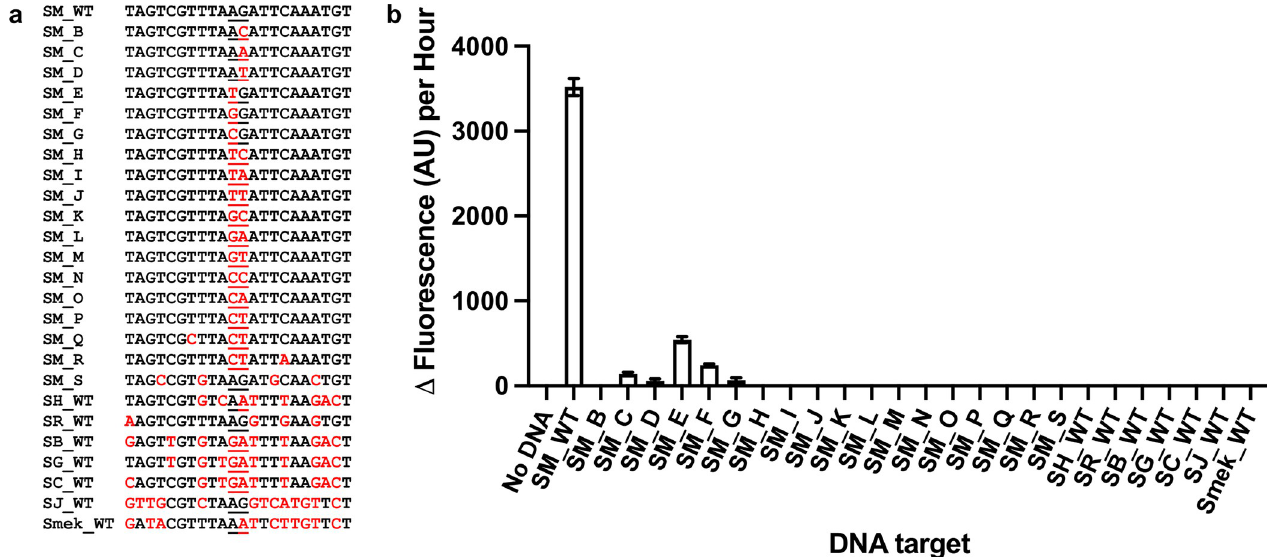
Fig 2. Biosensor ligation junction and S . mansoni probe set specificity. a , DNA targets tested. SM_WT is the target region probes SM_A1 and SM_B1 are designed to recognise. SM_B to SM_S have single, double or multiple base changes from that of SM_WT as indicated in red. The ligation junction for the probes is underlined. The corresponding target region for the other related Schistosoma species are indicated as follows: SR_WT ( Schistosoma rodhaini ), SH_WT ( Schistosoma haematobium ), SB_WT ( Schistosoma bovis ), SG_WT ( Schistosoma guineensis ), SC_WT ( Schistosoma curassoni ), SJ_WT ( Schistosoma japonicum ) and Smek_WT ( Schistosoma mekongi ). b , S . mansoni probes are specific for the S . mansoni wild-type target region. Both half probes and the target concentrations were tested at 50 nM. n = 9 (3 replicates per reaction, each reaction split into triplicate runs). Error bars denote standard error of the mean. The sequences of the probes are available in S1A